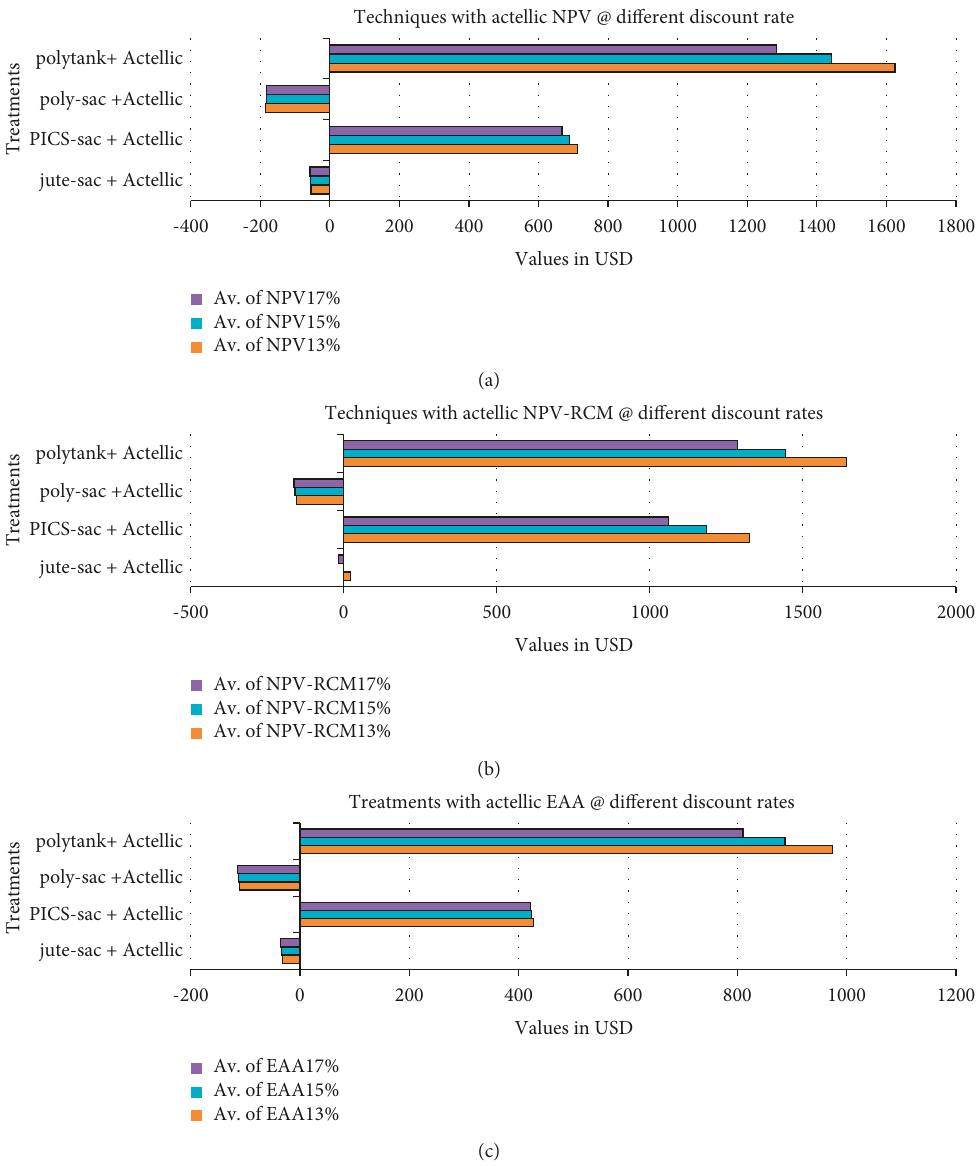
Figure 10: Performance of storage techniques treated with Actellic Supper in